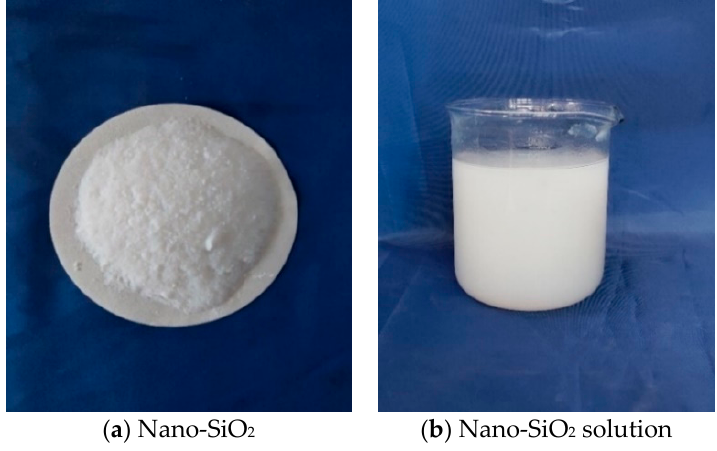
Figure 3. Nano-SiO 2 powder and solution.